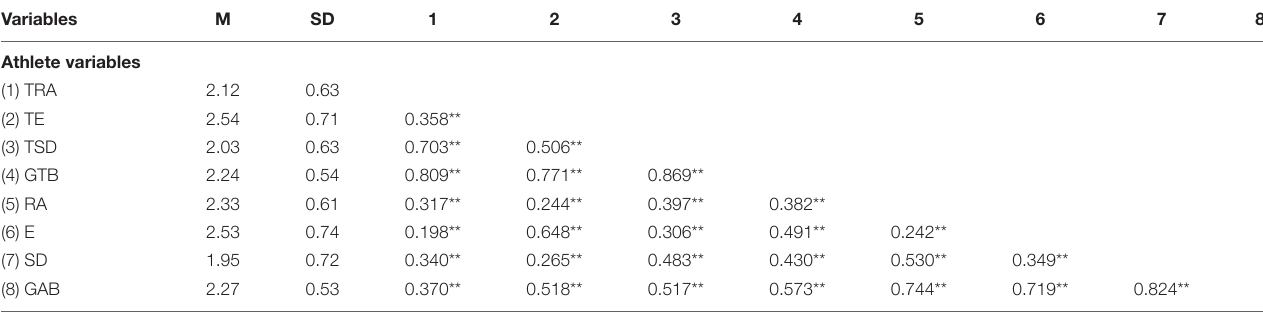
TABLE 1 | Descriptive statistics and bivariate correlations for all main variables under investigation.